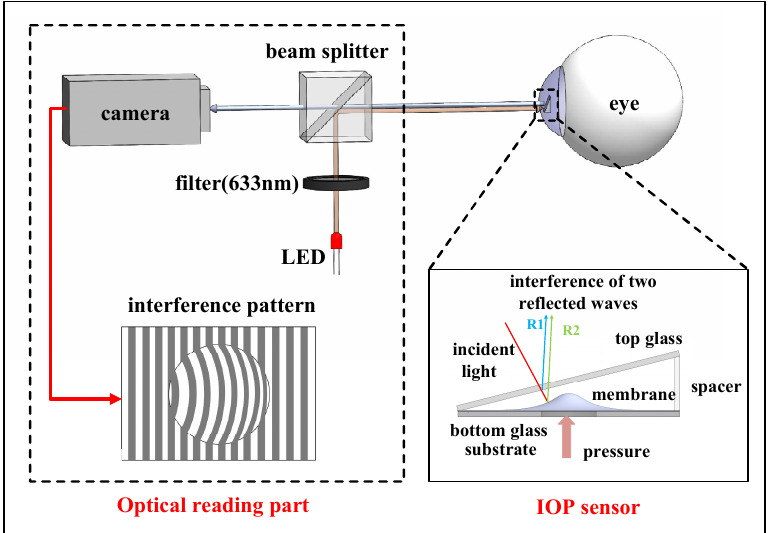
Figure 1. Optical intraocular pressure measurement system with implantable sensor and optical reading part.